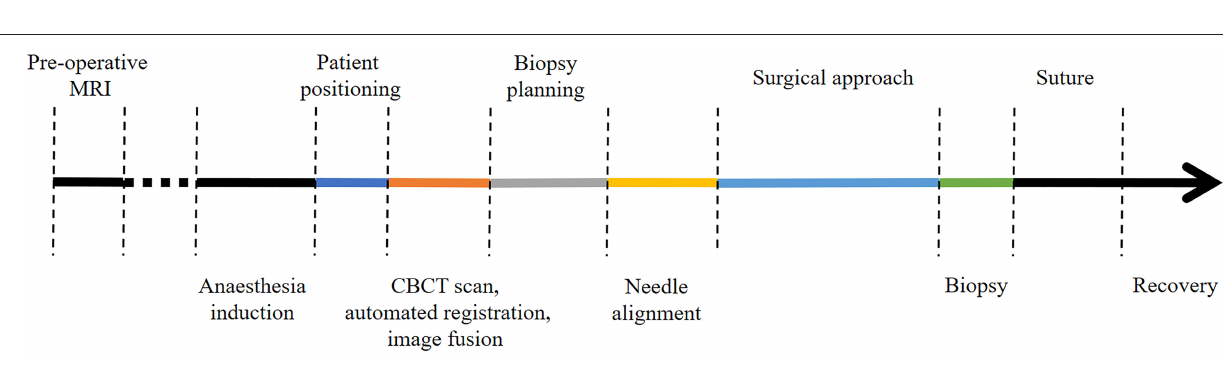
FIGURE 4 | Color coded timeline showing the different procedural steps. The time intervals of the colored procedural steps were